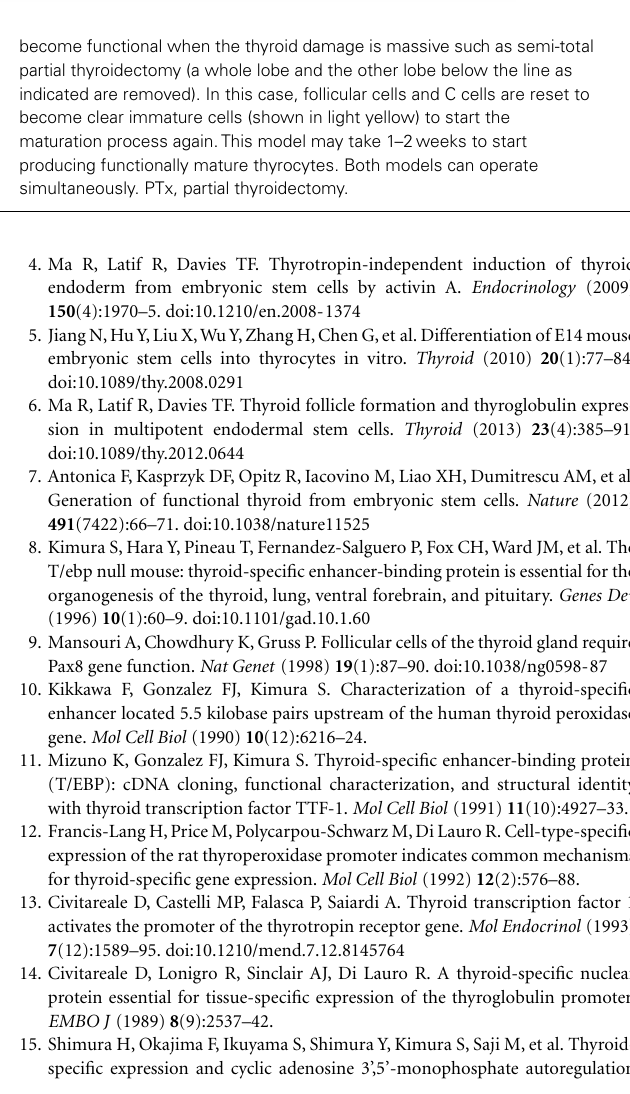
become functional when the thyroid damage is massive such as semi-total partial thyroidectomy (a whole lobe and the other lobe below the line as indicated are removed). In this case, follicular cells and C cells are reset to become clear immature cells (shown in light yellow) to start the maturation process again.This model may take 1–2weeks to start producing functionally mature thyrocytes. Both models can operate simultaneously. PTx, partial